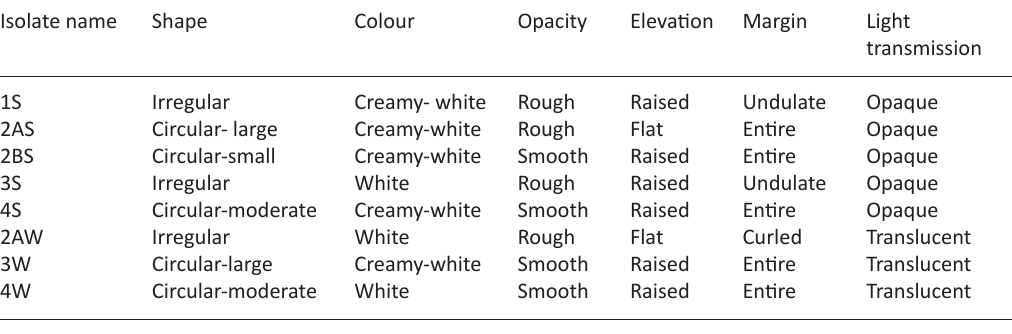
Table 2. Morphological features of isolates Isolate